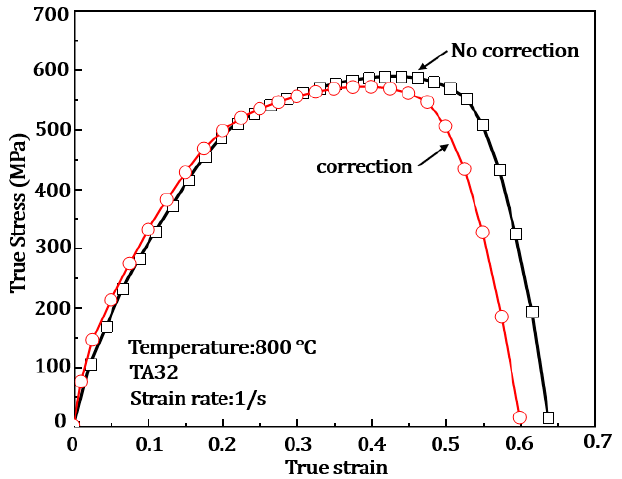
Figure 9. Experimental stress-strain curves with and without correction. The temperature is 800 °C, and the strain rate is 1/s.